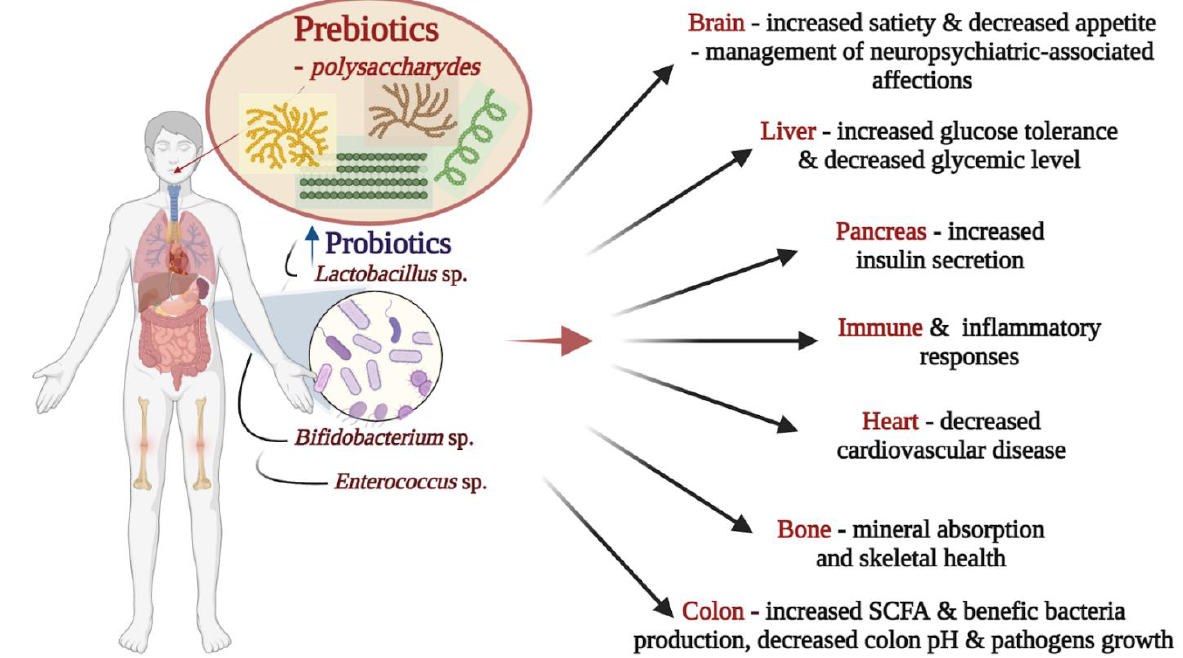
Figure 5. Prebiotic consumption and its possible impact on human health (image created using the BioRender application;